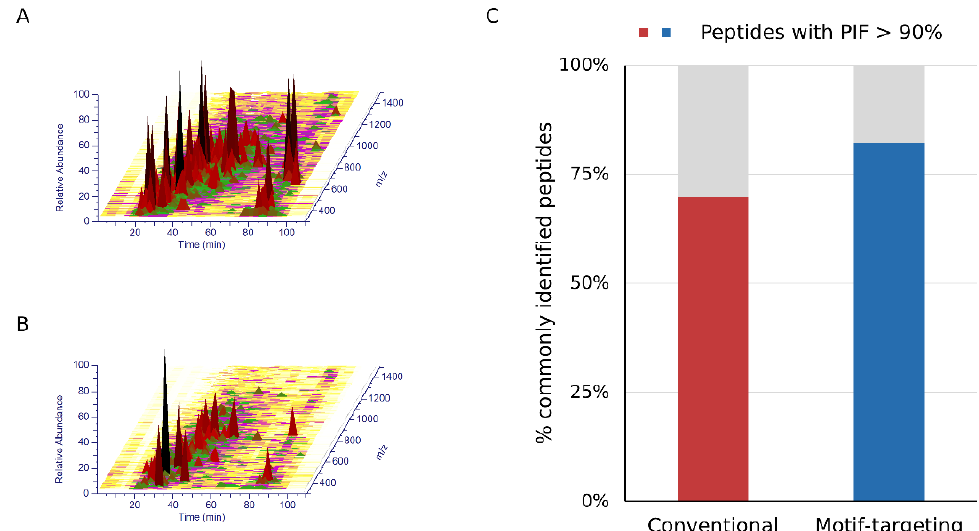
Figure 3. The complexity of the samples. A, B. LC/MS spectrograms obtained by conventional ( A ) and motif-targeting ( B ) workflows. The peaks are colored by their abundances. ( C ) The bar chart shows the ratios of high-purity matches (PIF > 90%) among the peptides commonly identified by the conventional and motif-targeting